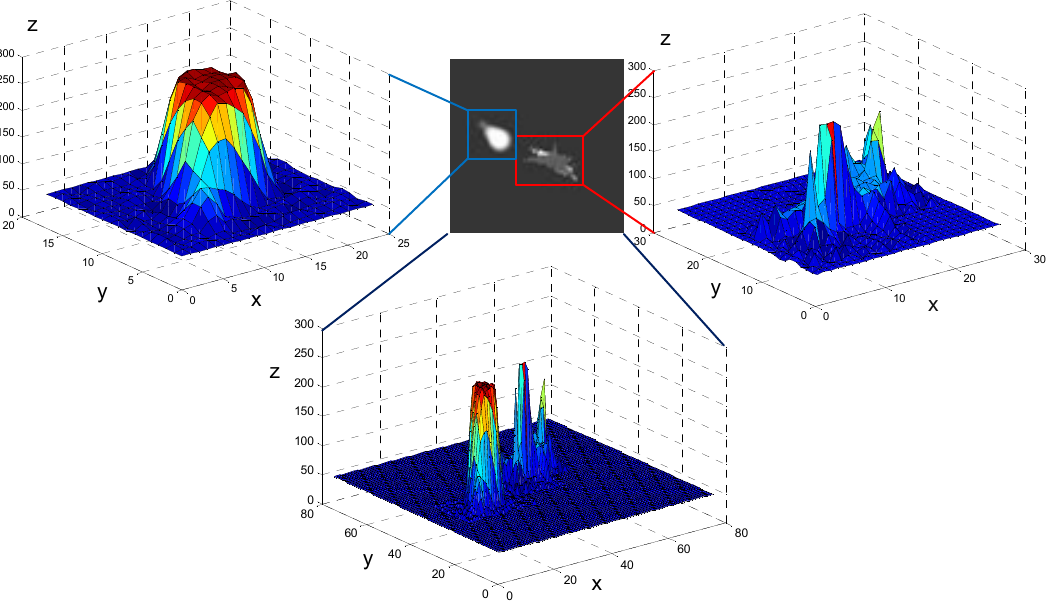
Figure 3. Aircraft and decoy infrared signatures. The figures in the upper left and upper right correspond to the decoy and the aircraft respectively. The infrared signatures show significant diffidence in the aircraft and the decoy. The x, y, and z coordinates represent the row, column, and gray-level values of the